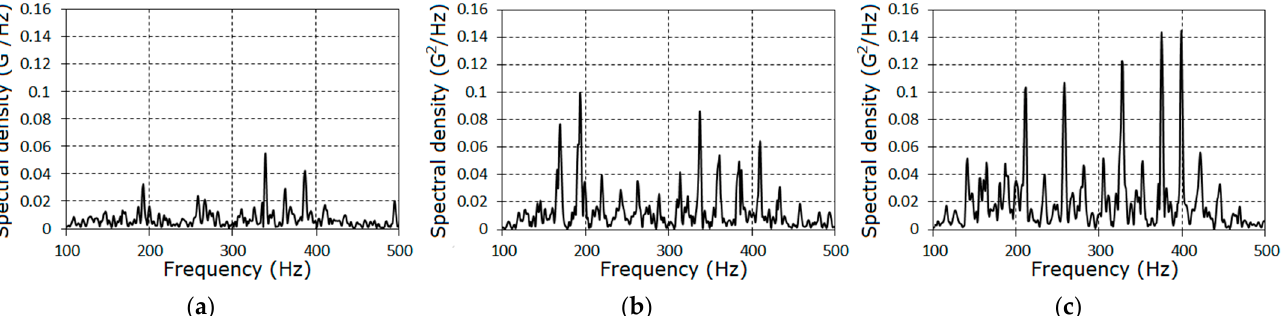
Figure 10. The estimators of the spectral densities of the vibration of stochastic parts in the low-frequency domain for the first ( a ), the second ( b ) and the third ( c ) stages.